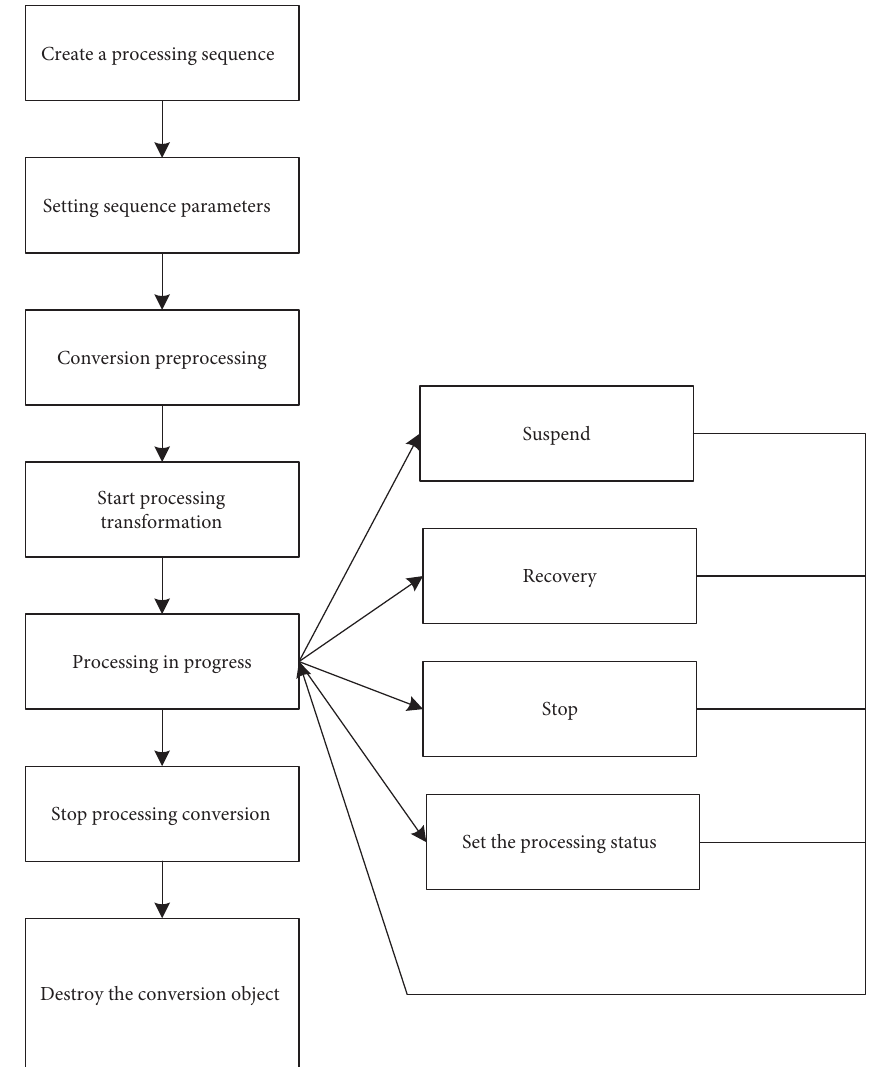
Figure 1: Flow of multimedia data processing